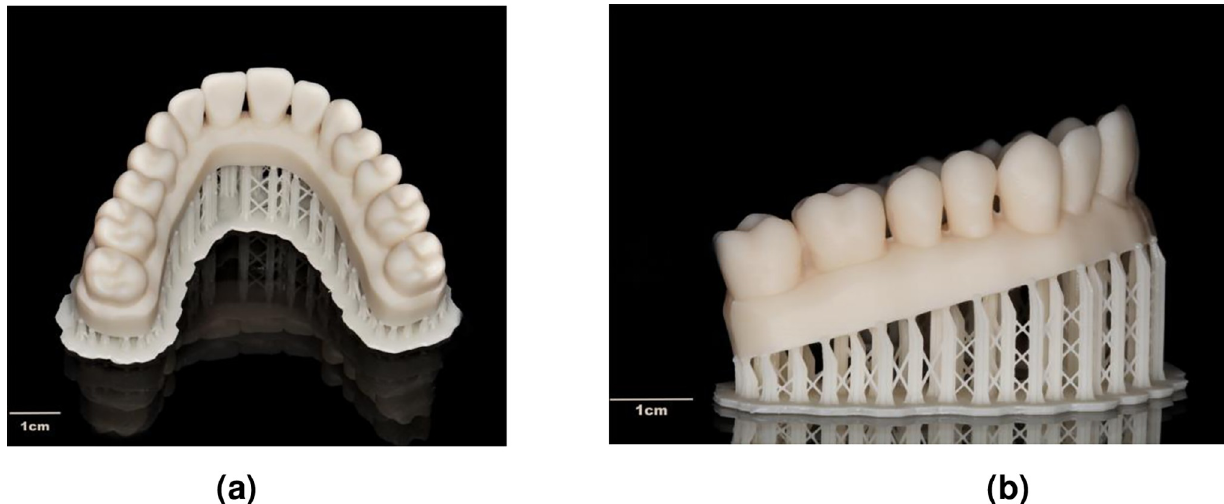
Fig 4. (a) and (b) Printed cast with its attached support